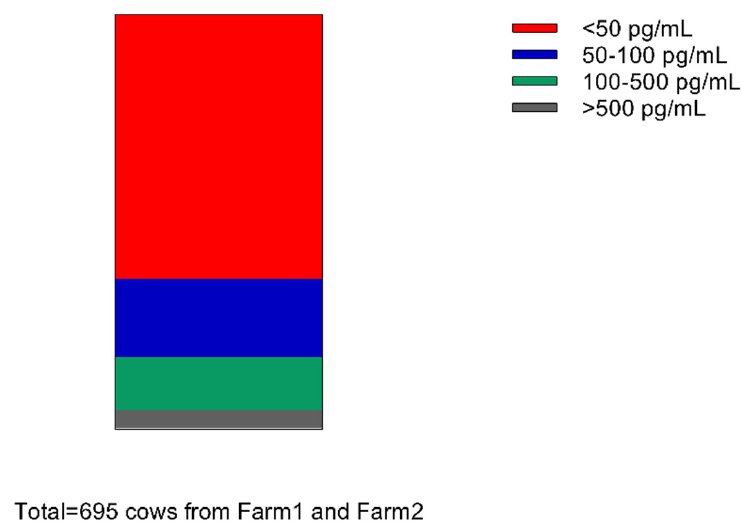
Figure 1. MT level distribution of 695 milk samples. Table 1. Pearson correlation analysis between MT in milk and DHI